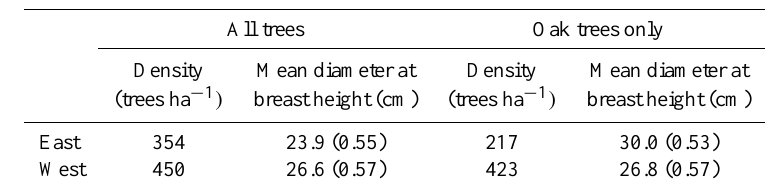
Table 2. Annual eddy covariance CO 2 flux data capture and